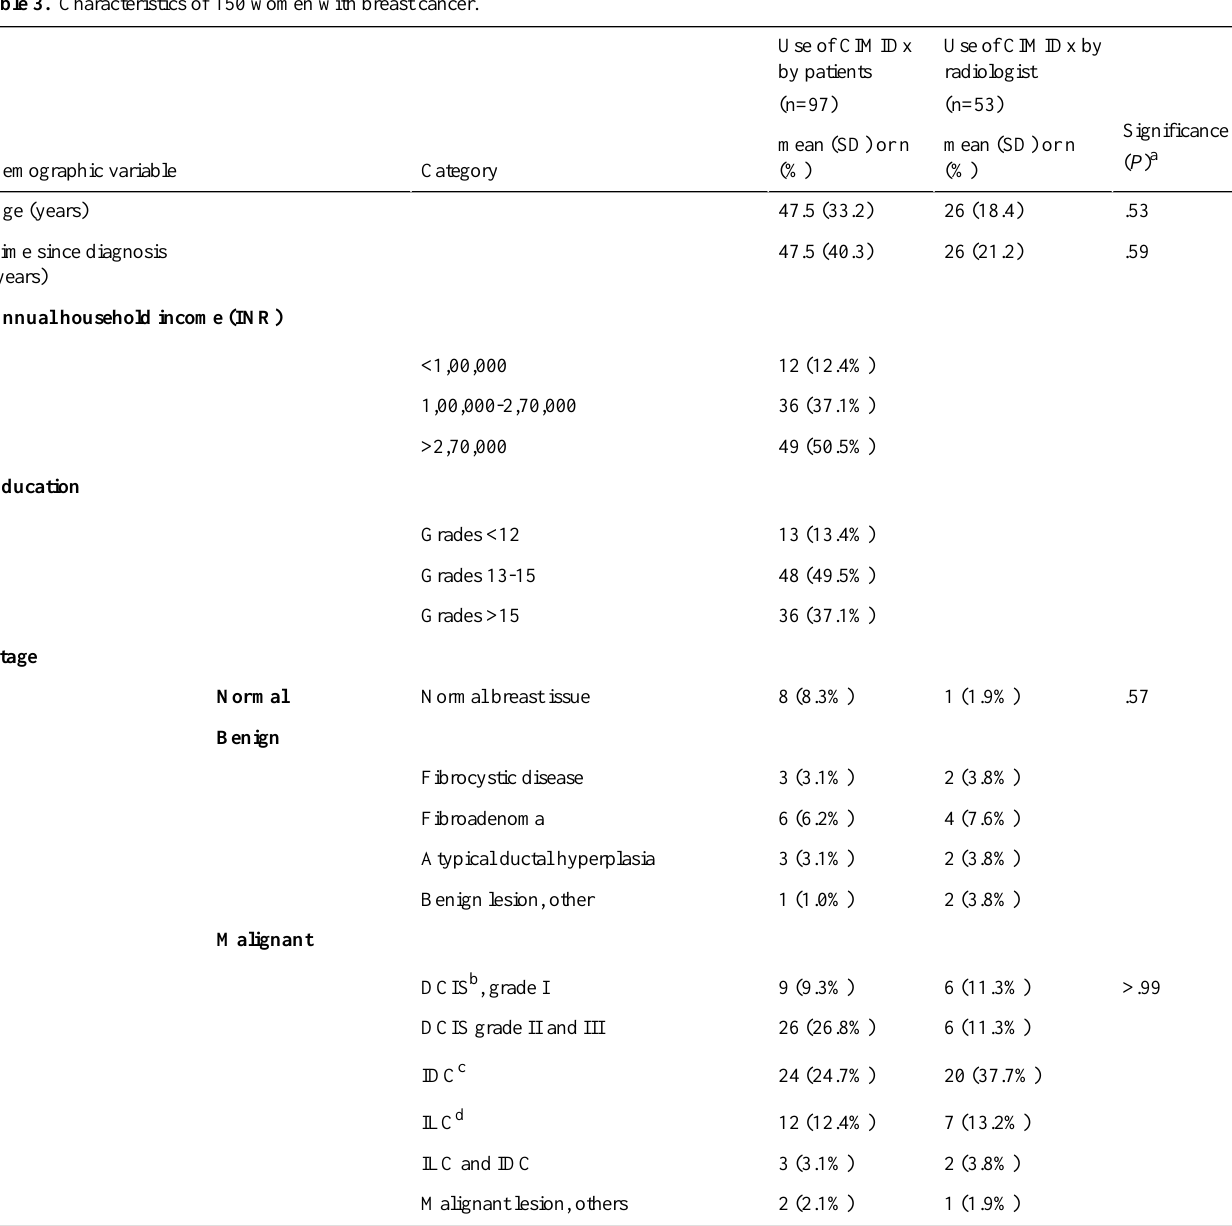
Table 3. Characteristics of 150 women with breast